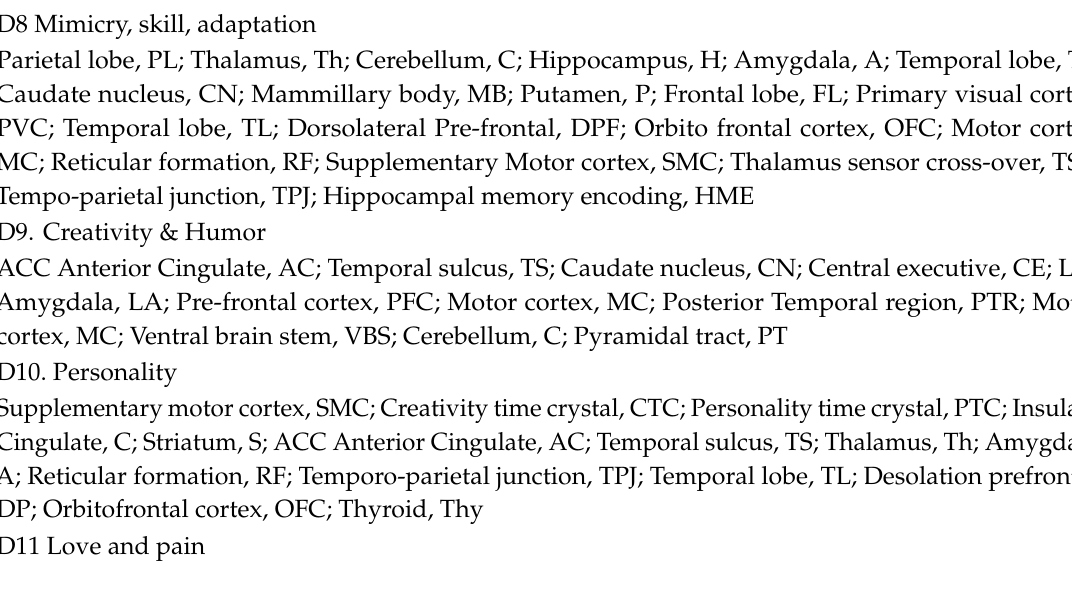
Figure 17. Dodecanions and octonions [41].